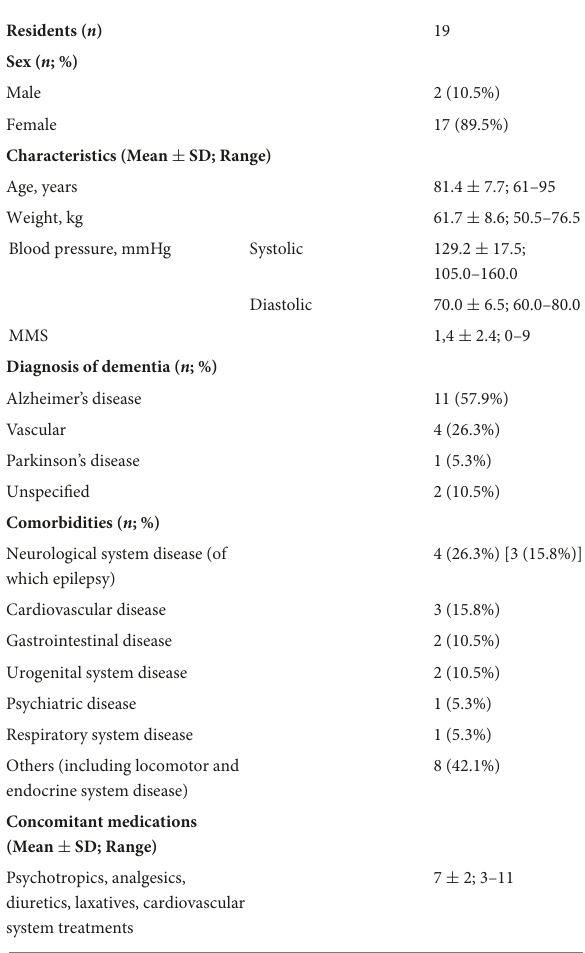
TABLE 1 Baseline characteristics.